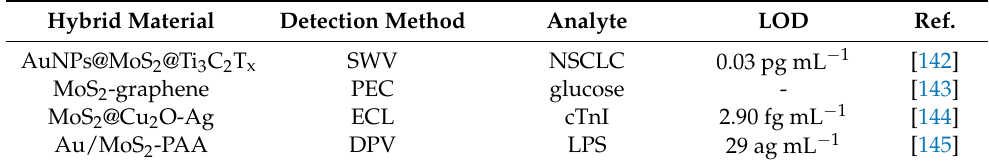
Figure 11. ( a ) The structure of a single-layered MoS 2 or WS 2 . The Mo or W atoms are in black and the sulfur atoms are in yellow. ( b ) The structure of GO showing rich oxygenated groups: the carbon atoms in black, oxygen in red, and hydrogen in grey (Reprinted with permission from Ref. [143]. Copyright 2021, Elsevier). Table 6. Biosensors based on MoS 2 NPs.